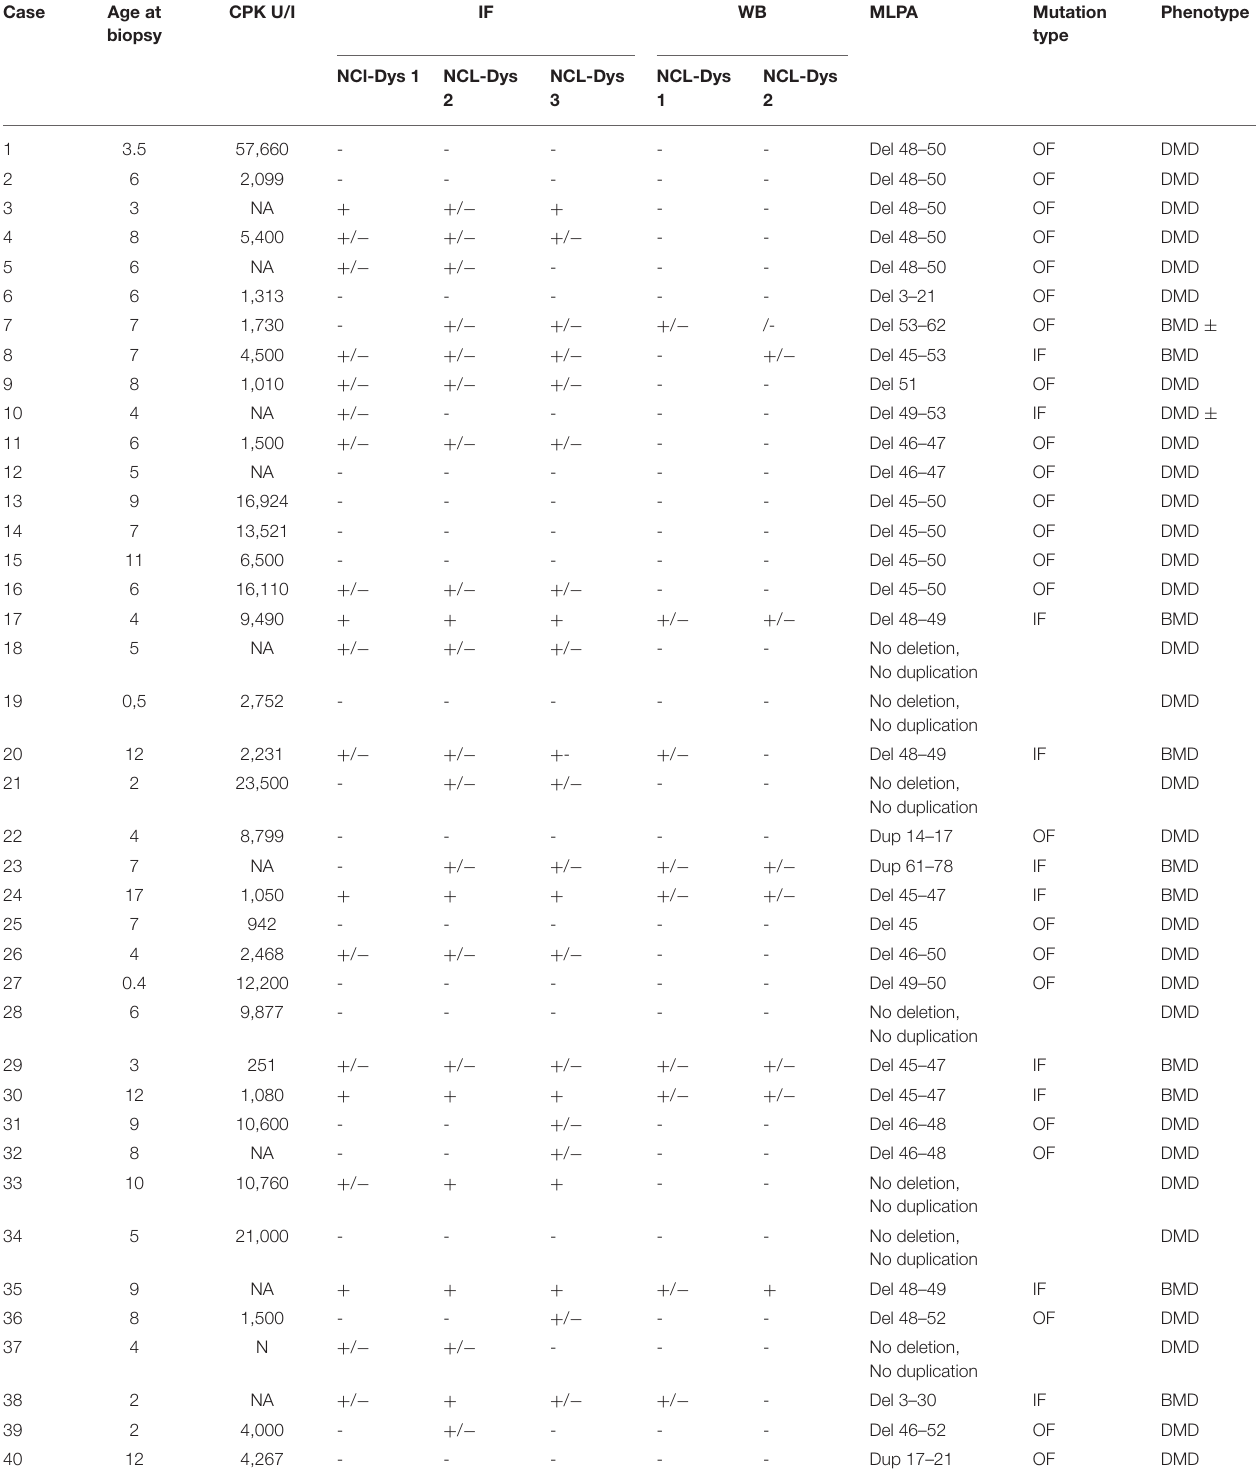
TABLE 1 | The baseline characteristics of the study male